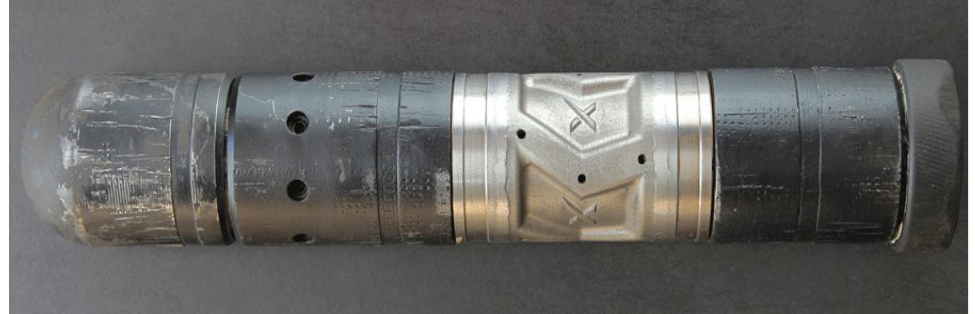
Figure 4. Additively manufactured Inconel 718 nozzle component [44]. Table 7. Active damage mechanisms of the stainless-steel nozzle in downhole applications.